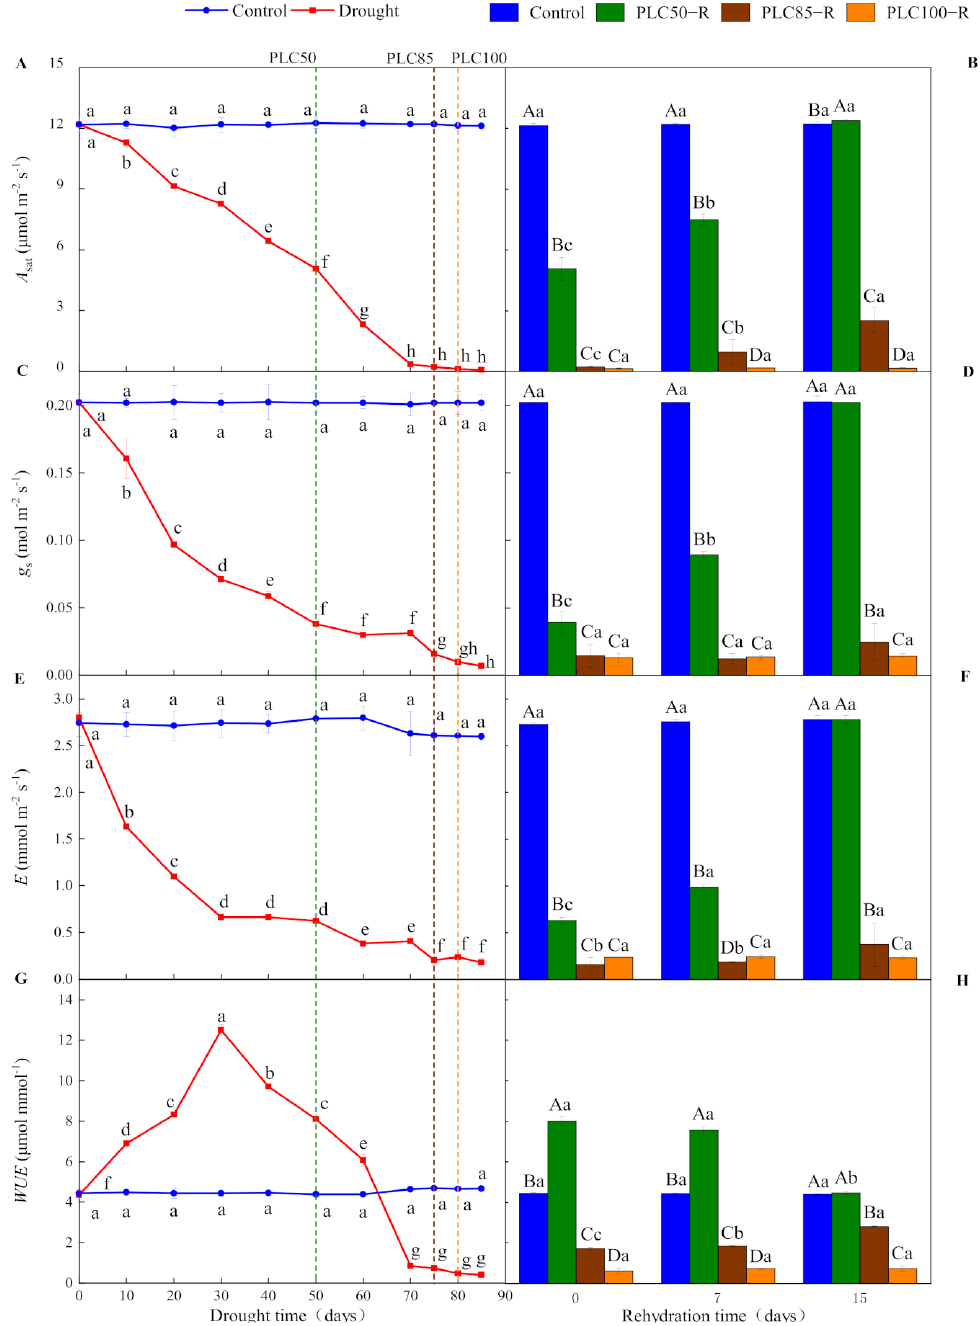
Figure 2. Dynamics in the gas exchange of Pinus massoniana seedlings during drought and subsequent rehydration. Panels ( A , C , E , G ) represent the dynamics of A sat , g s , E and WUE under drought treatment, and panels ( B , D , F , H ) represent the dynamics of A sat , g s , E and WUE after subsequent rehydration. Different lowercase letters indicate significant differences between sampling dates within the same treatment ( p < 0.05), while different capital letters indicate significant differences between treatments on the same sampling date ( p < 0.05). Dashed lines represent the time when PLC reached 50% (PLC50, green), 85% (PLC85, brown), or 100% (PLC100, orange), while rehydration (PLC50 − R, PLC85 − R, and PLC100 − R, respectively) followed immediately. Values represent means ± SD ( n =